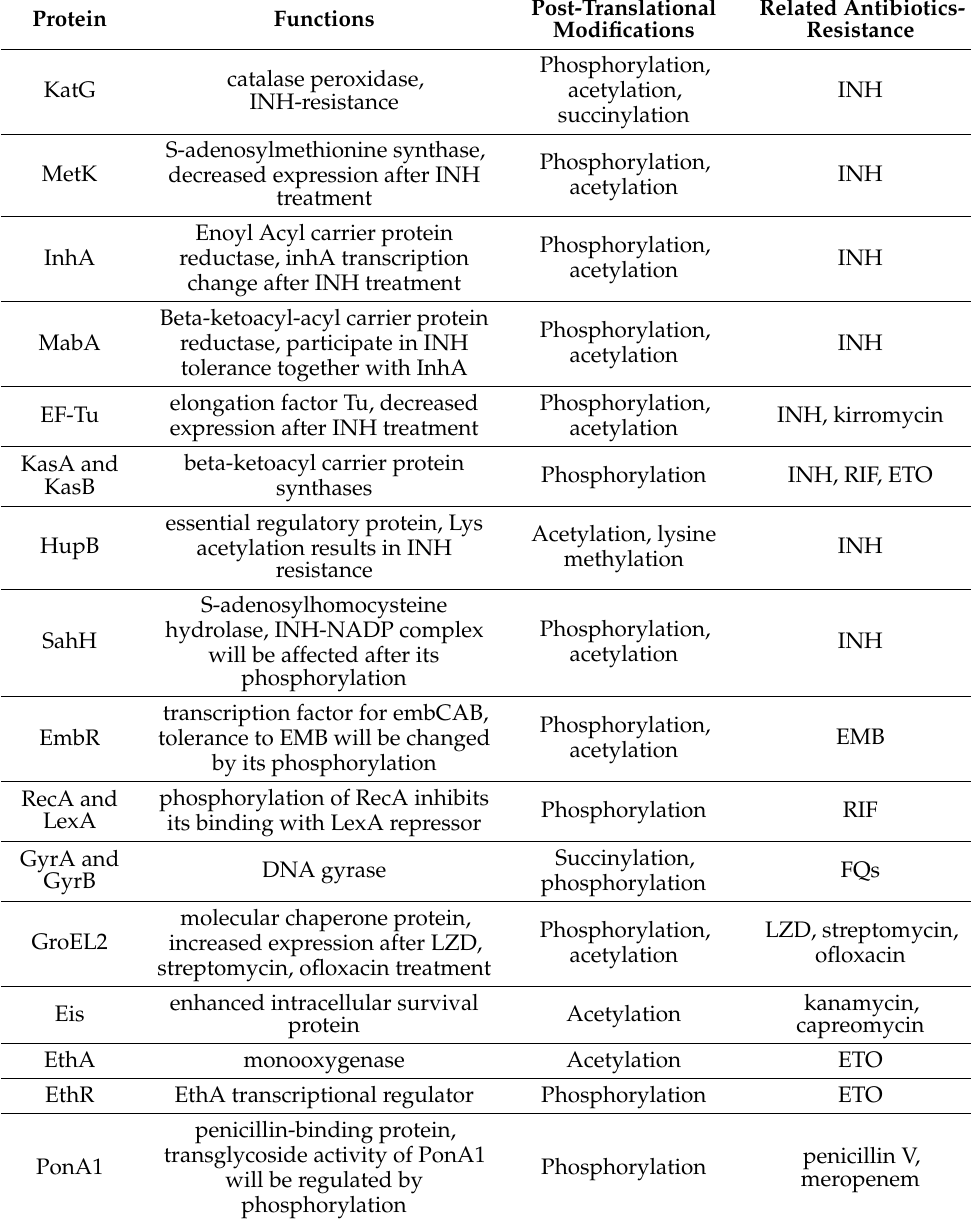
Post-Translational Related Antibiotics- Modifications Resistance Phosphorylation, INH acetylation, succinylation Phosphorylation, INH acetylation Phosphorylation, INH INH